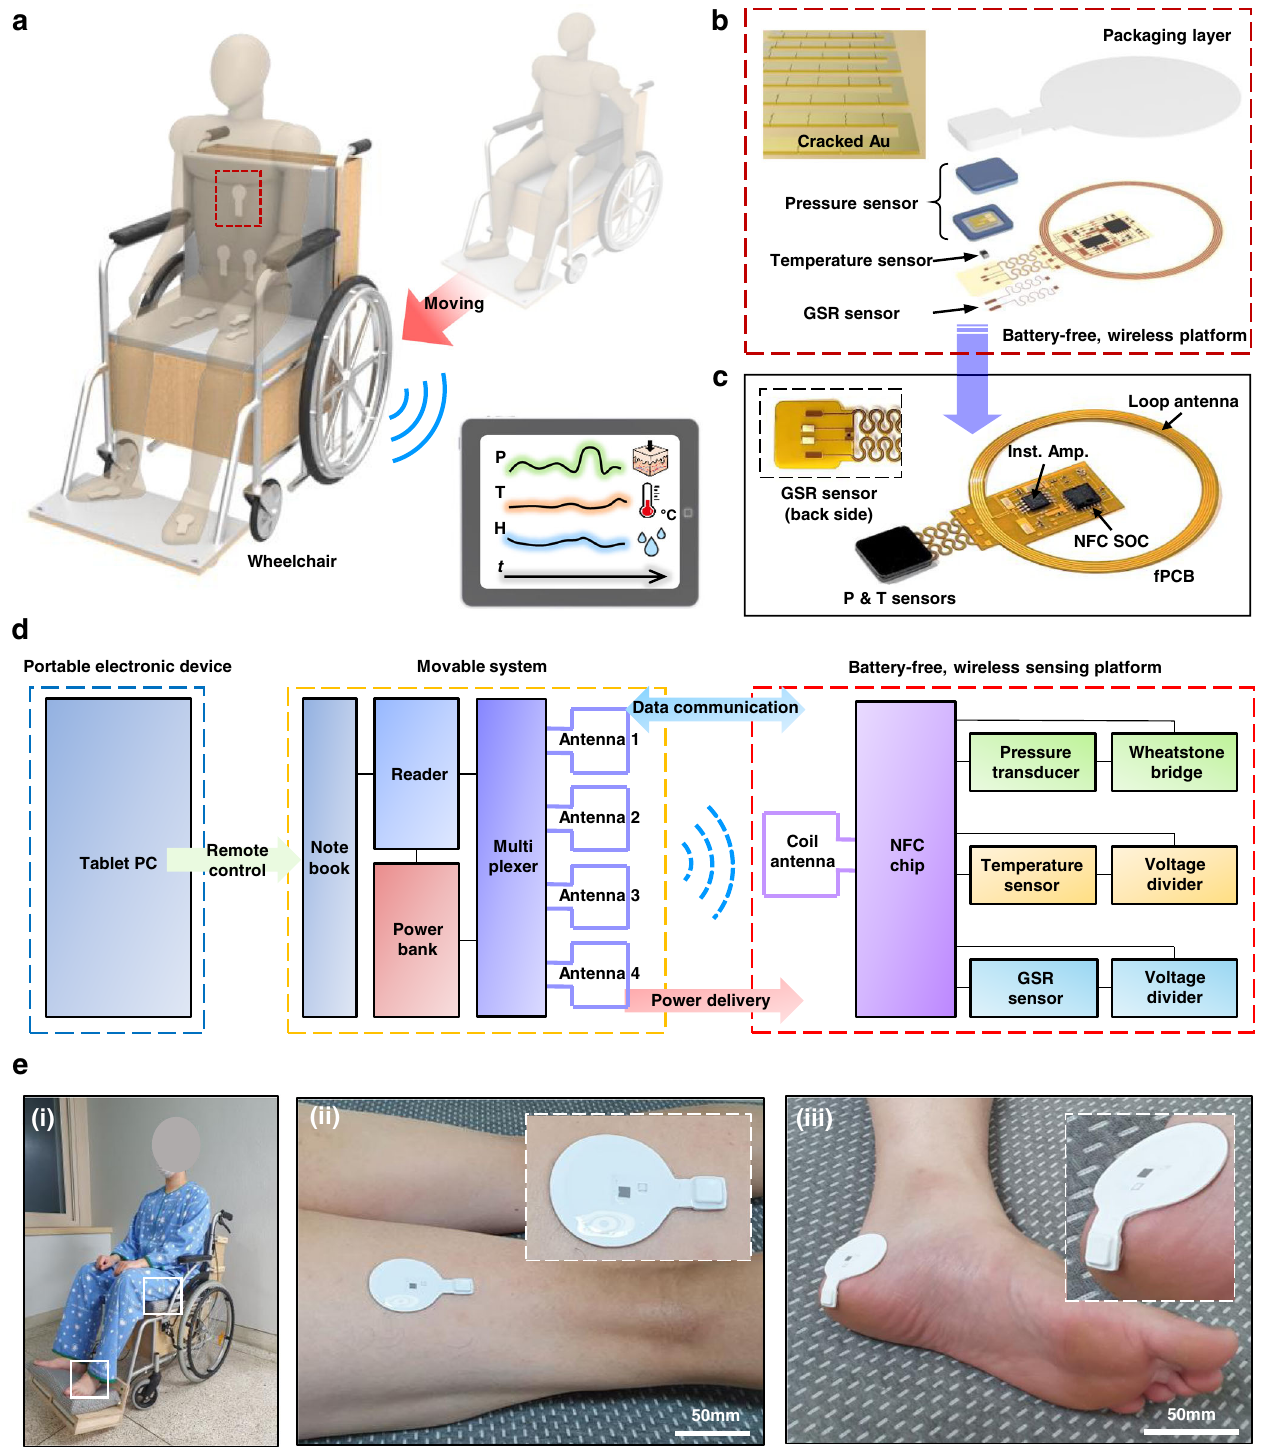
Fig. 1 Schematic illustrations, photographs, and overview of battery-free, wireless sensing platform and movable system. a Schematic illustration of the movable system. b Schematic illustration of the battery-free, wireless sensing platform that includes crack-activated pressure sensor, temperature sensor, and GSR sensor. c Photograph of the sensing platform. Inset shows the GSR sensor located at the back side of fl exible PCB. d Block diagram of the overall system. e (i) Photographs of the subject sitting on a wheelchair. Photograph of the devices mounted at two mounting locations, including (ii) Posterior thighs. (iii) thighs and heels that are high-risk regions for developing the (Supplementary Fig. 2) In addition, a serpentine interconnector pressure injuries caused by sitting. The thin, soft PDMS packaging between the multimodal sensors and NFC SoC/receiver coil of the device mechanically and electrically protects the electronics supports conformal contact of the multimodal sensor to the from bio fl uids and prevents the device from damaging skin. curved skin and stable detection of signals even under postural